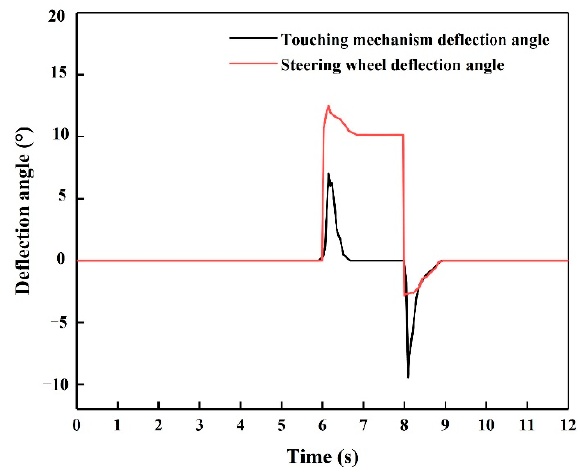
Figure 13. Simulation results.